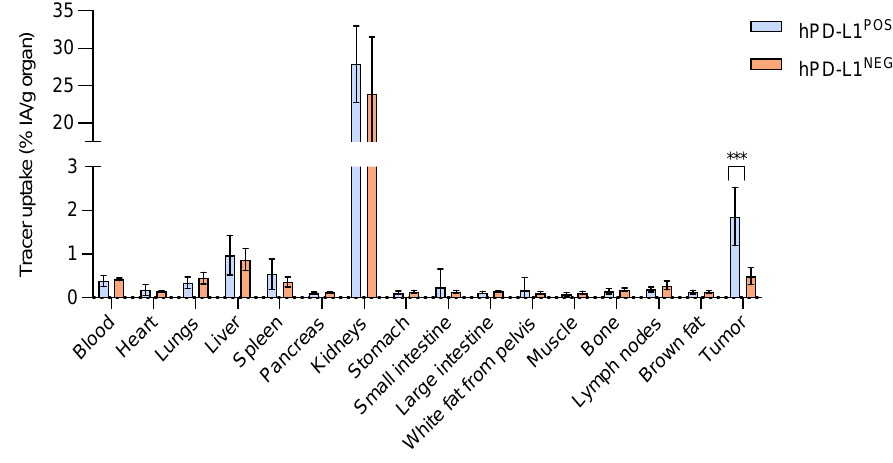
Figure 4. Biodistribution profile and tumor targeting of the [ 68 Ga]Ga-NOTA-mal-(hPD-L1) Nb at 80 min post-injection in hPD-L1 POS tumor-bearing mice ( n = 12) and in hPD-L1 NEG tumor-bearing mice ( n = 6), showing a significant difference (***, p < 0.001) between hPD-L1 POS and hPD-L1 NEG tumor uptake.